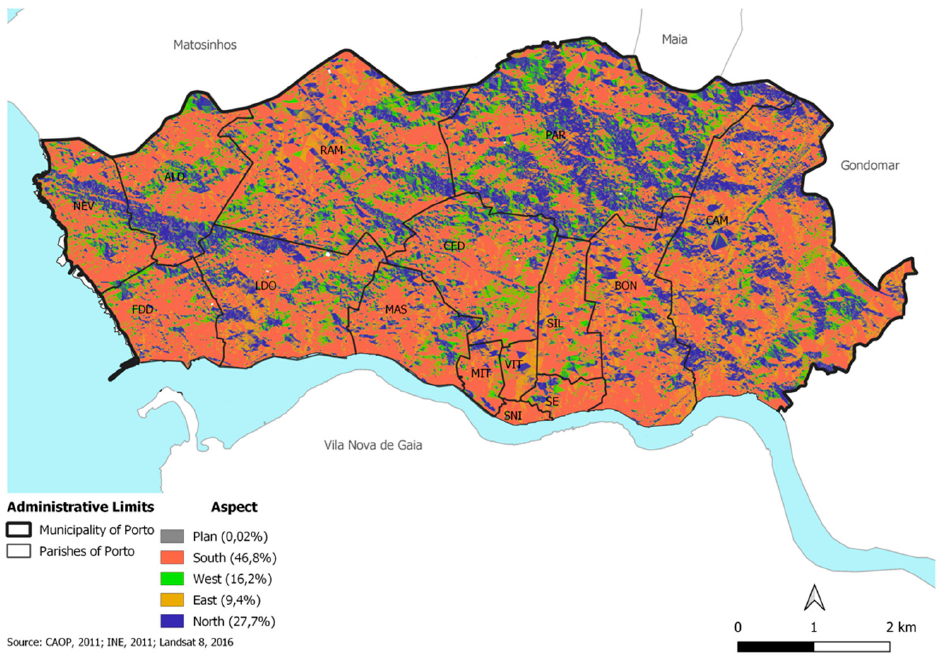
Figure 2. Porto’s slope exposure [31].